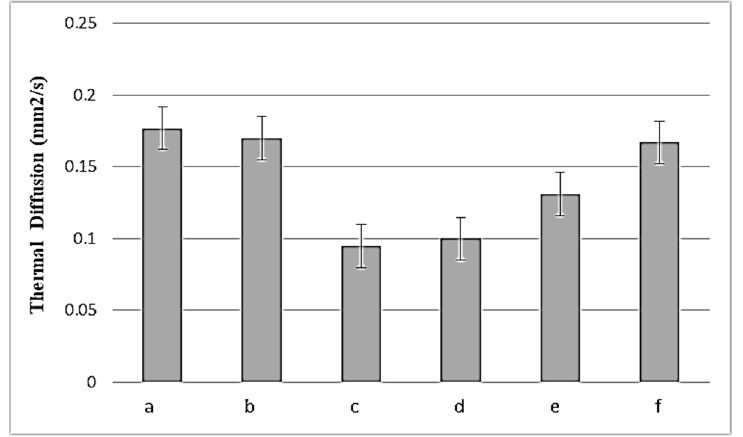
Figure 5. Thermal diffusion values for each specimen versus % content in CaCl 2 based on one way ANONA ( p < 0.01). a: untreated; b: 10 wt % CaCl 2 ; c: 25 wt % CaCl 2 ; d: 50 wt % CaCl 2 ; e: 5 washes for b samples; f: 10 washes for b samples. The data are represented as mean ± SD.